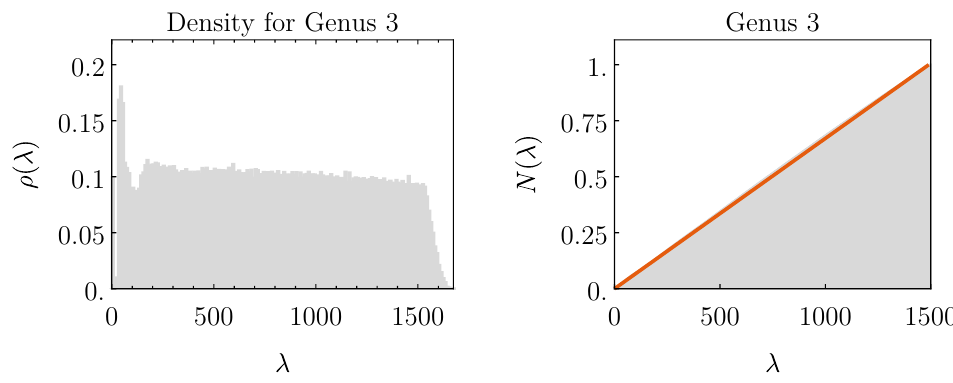
Figure 3 . On the left, we show the eigenvalue density for the Laplacian on genus-3 curves drawn from an ensemble of 1,000 samples in complex structure moduli space with each sample containing the lowest-lying 160 eigenvalues. The peak at λ is due to the zero-mode which is present in every instance of the ensemble. On the right, we show the integrated eigenvalue density up to λ = 1500 together with the asymptotic number of eigenvalues predicted by Weyl’s law (4.6) in